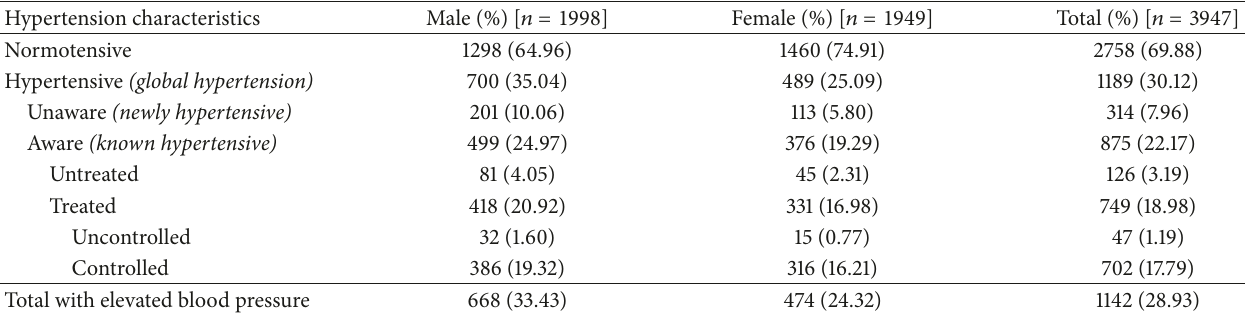
Table 2: Demonstrating hypertension characteristics, by